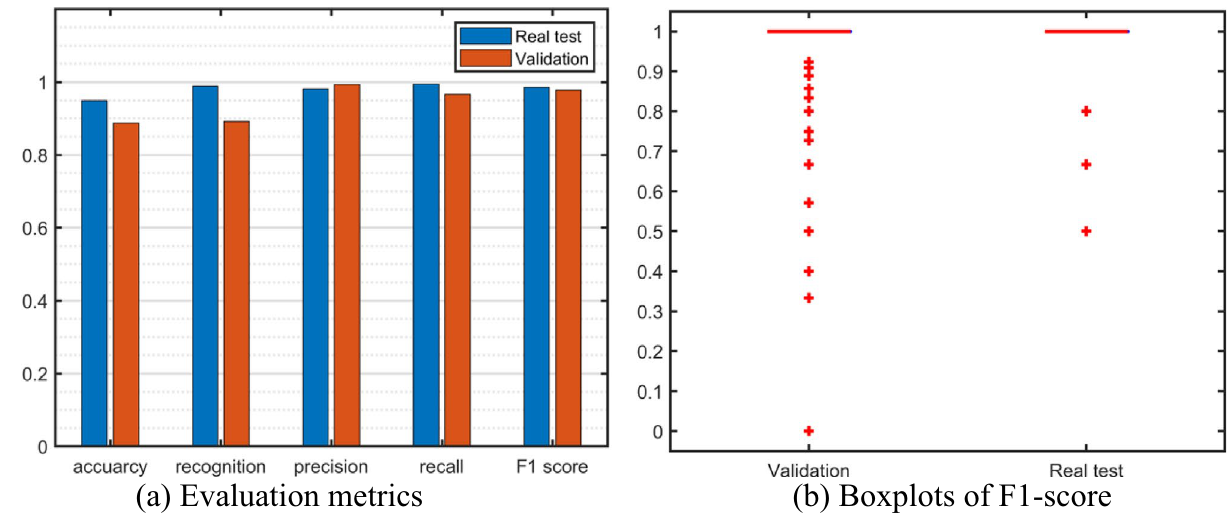
Figure 6. Performance of the well-trained CNN-BiLSTM